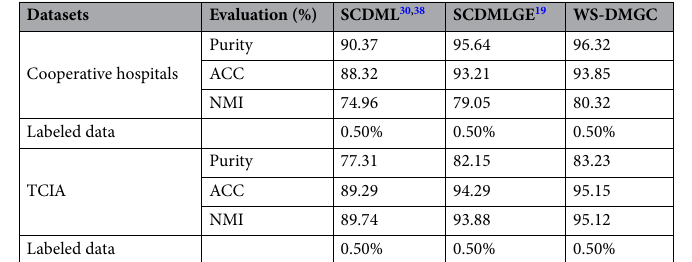
Table 6. Performance comparison of different algorithms on two datasets based on Purity, ACC and NMI.